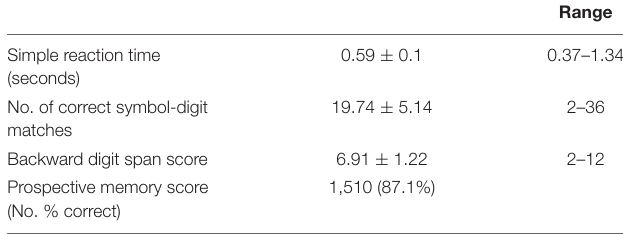
TABLE 3 | Summarizing the number of individuals in each activity group, for the MRI and cognitive